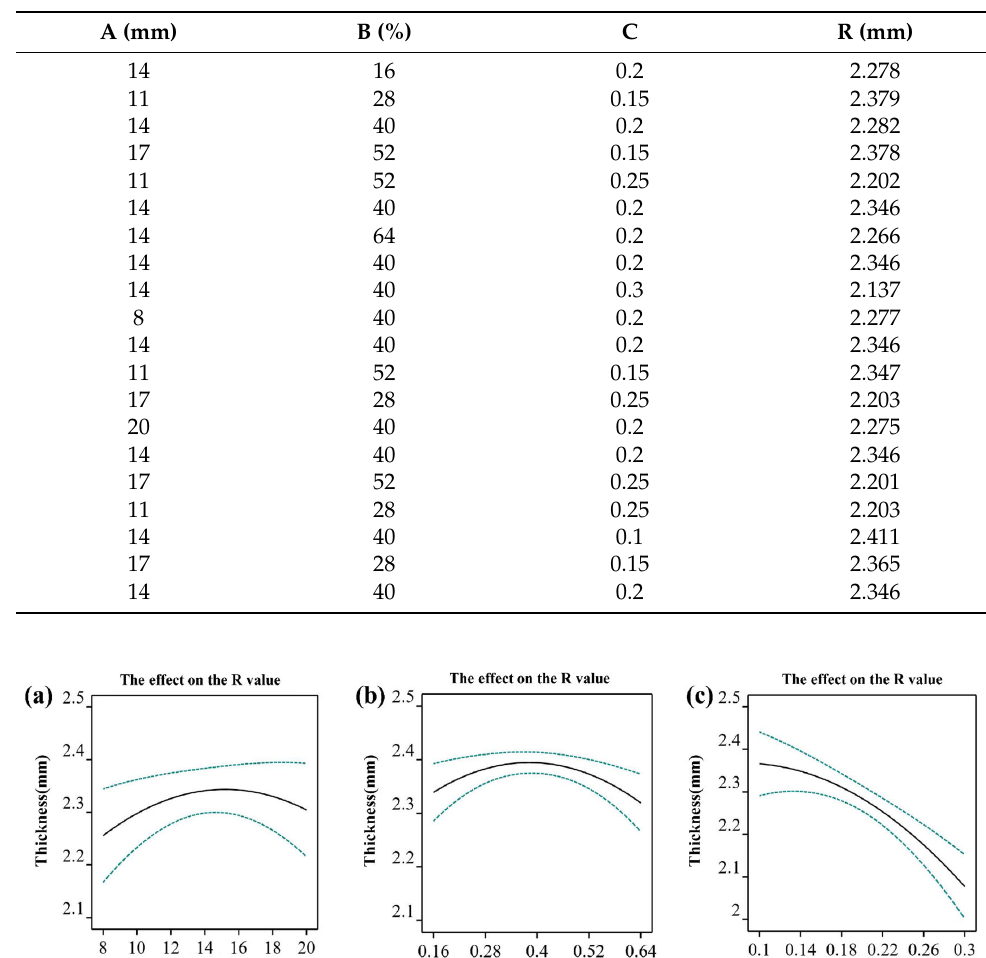
Table 2. Experimental design and results.